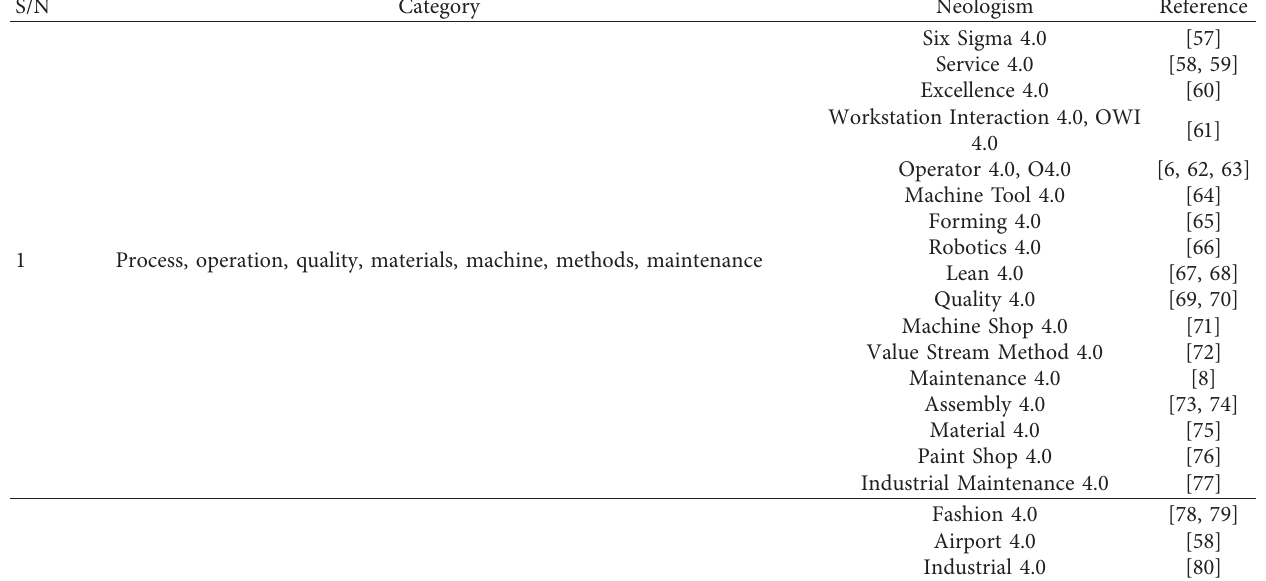
Table 2: Industry 4.0